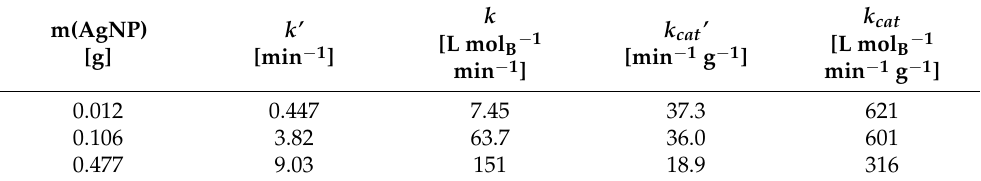
Figure 7. ( a ) The 4-NP absorbance ratio for in- and outflow vs. mobile phase flow rate. ( b ) Absorbance ratio vs. retention time for the determination of the apparent rate constant ( k’ ) from regression analysis for samples with various loadings of catalyst (see Figure 3b) according to Equation (3). Table 1. Reaction constants for the samples with various loadings of catalyst (see Figure 3b) calculated according to Equations (1) and (2). NaBH 4 concentration was 60